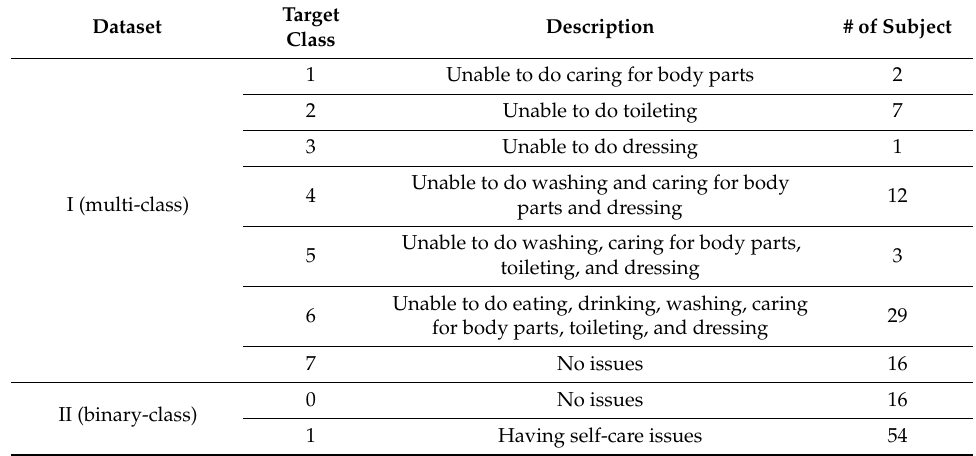
Table 3. The target class and description for each dataset used in this